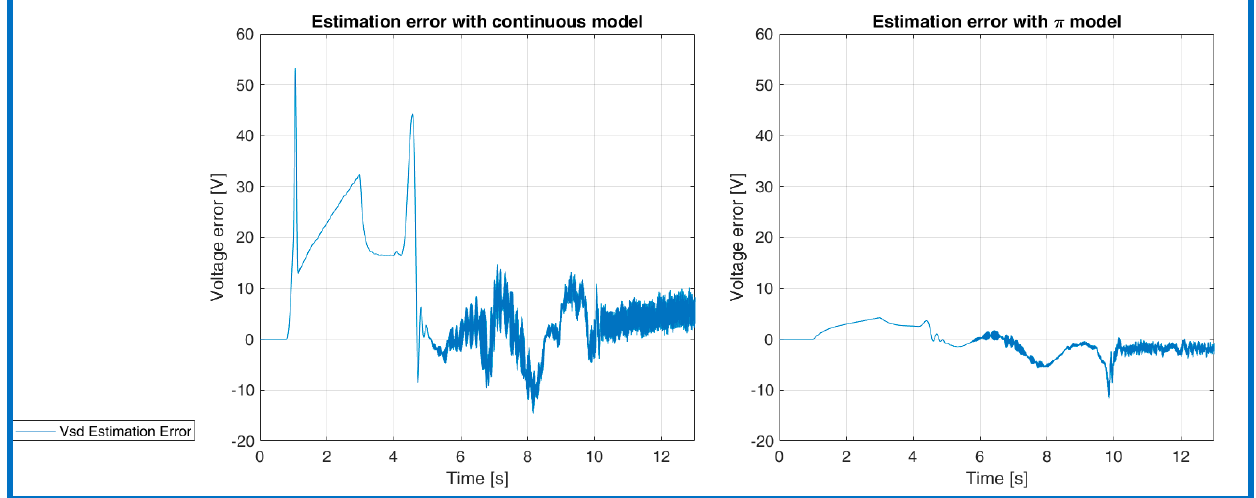
Figure 18. Estimation error with the continuous model of the line (left) and with the π model (right).